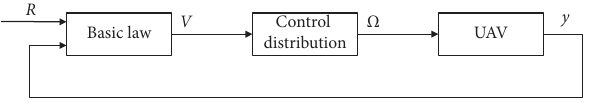
Figure 2: Block diagram of control distribution structure. Table 1: Hexarotor UAV simulation structure parameter